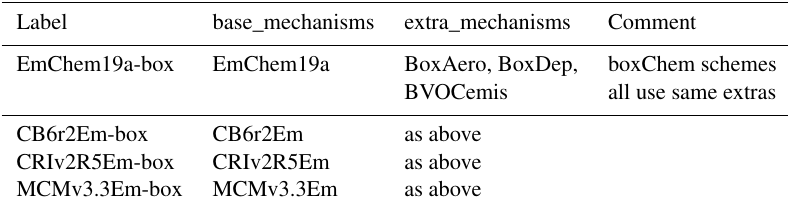
Table 4. Examples of base and extra mechanisms associated with boxChem configurations.